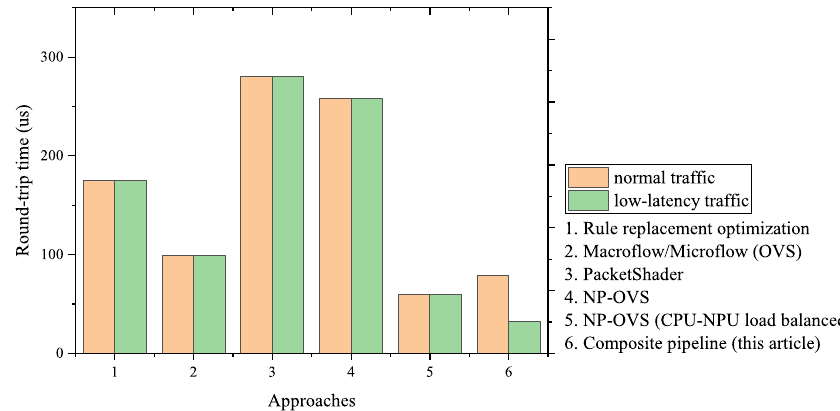
Figure 16. The round-trip time of normal/low-latency traffic in each approach. Table 4. The average round-trip time and the reliability of traffic in the three